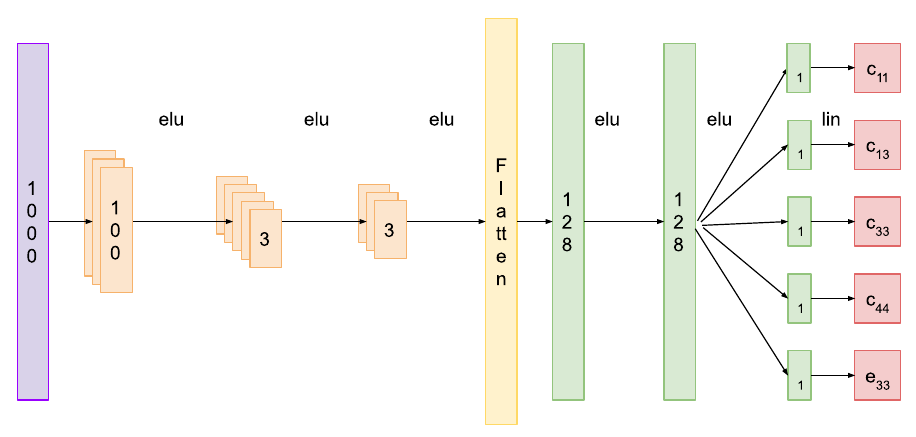
Figure 3. Architecture of the proposed Neural Network.